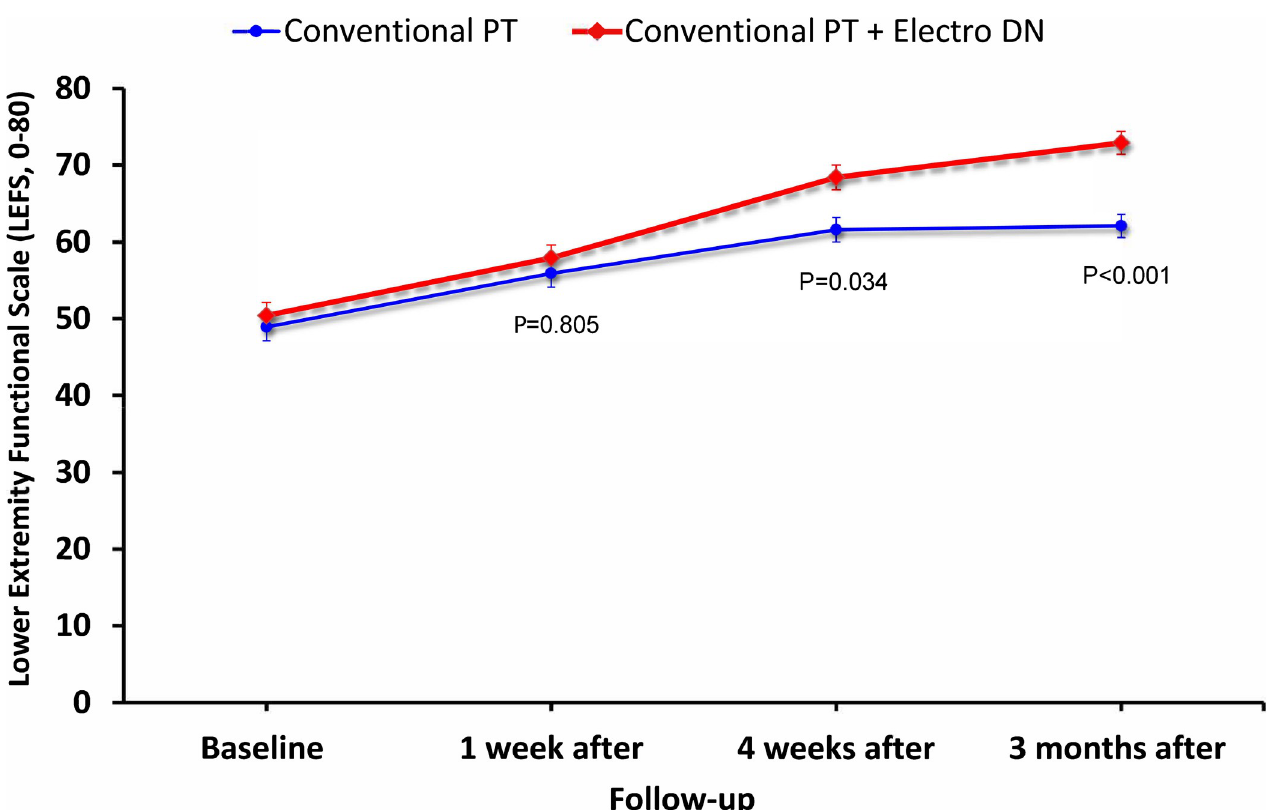
Fig 4. Evolution of lower extremity function (LEFS, 0–80) throughout the course of the study stratified by randomized treatment assignment. Data are means (standard error).